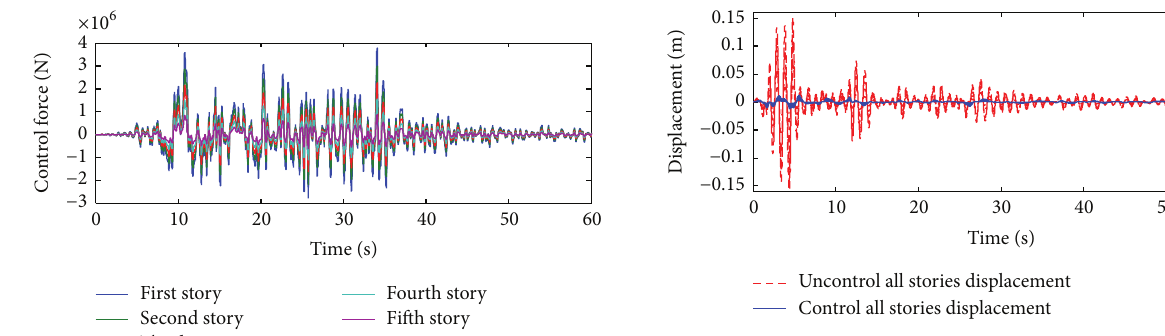
Figure 12: Displacements of all five floors for uncontrolled and synchronized control coupled with 𝐻 2 / LQG algorithm in El Centro Earthquake (1940).